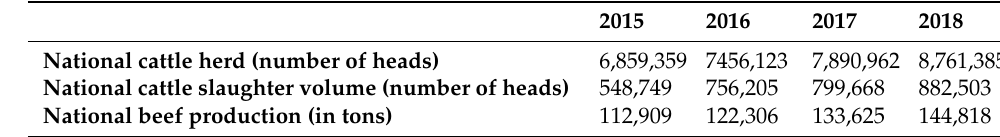
Table 1. Some statistics of the beef